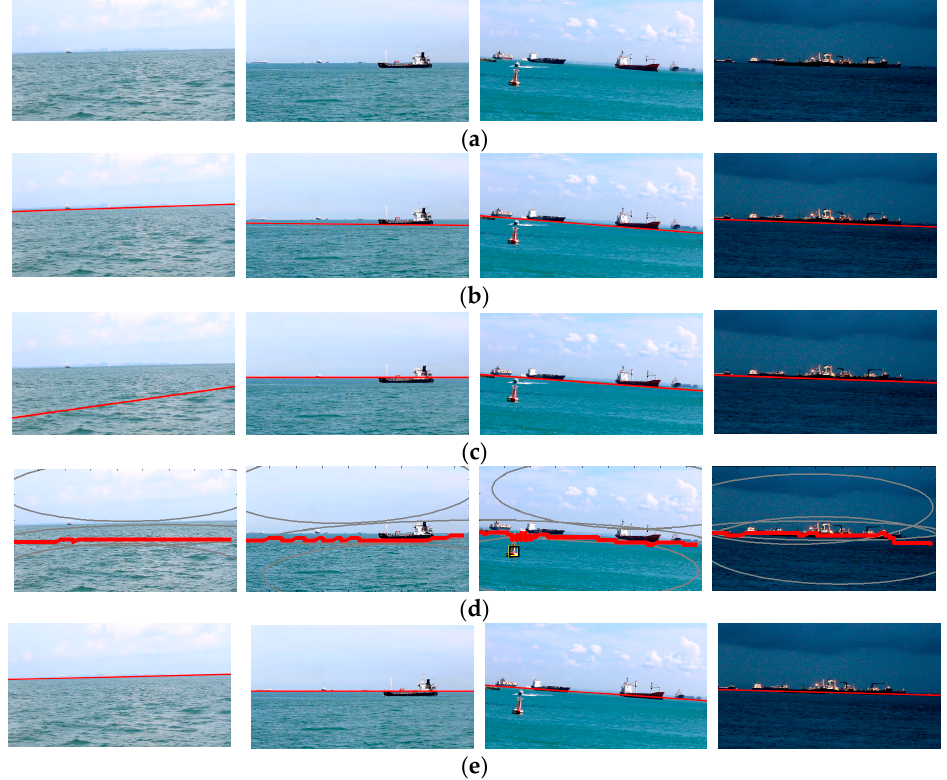
Figure 11. A comparison of various horizon line detection methods using SMD: ( a ) Original image; ( b ) Wang’s algorithm; ( c ) MSCM-LiFe; ( d ) SSM; ( e ) CFS method.